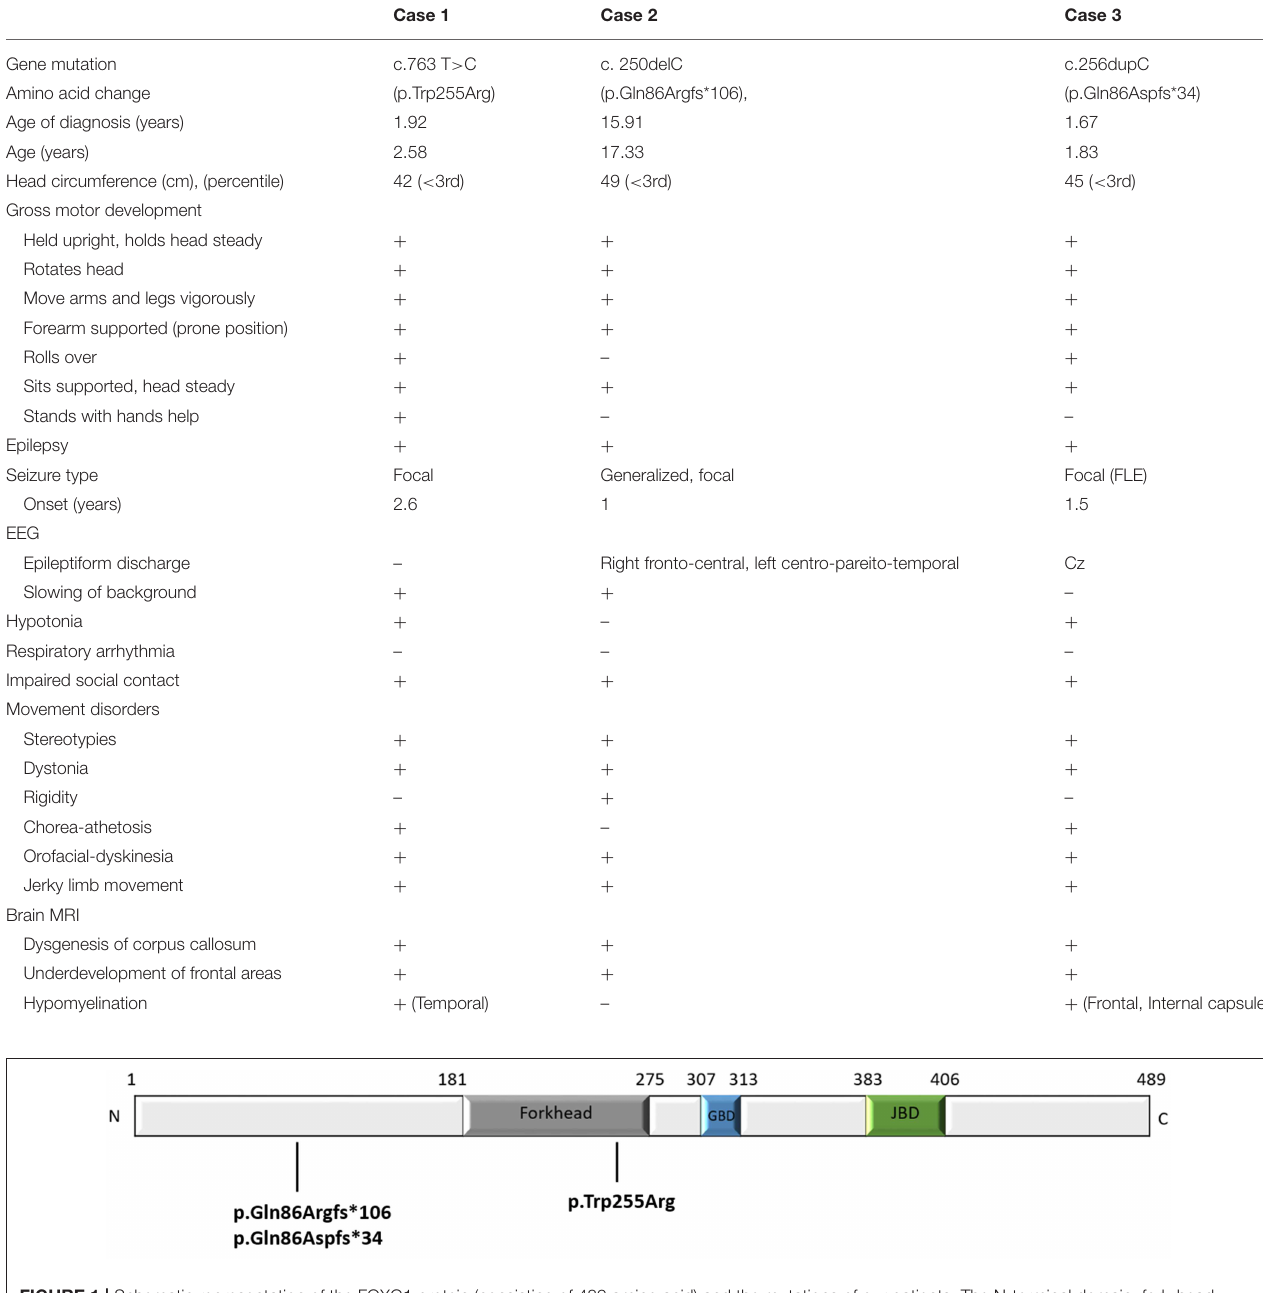
TABLE 1 | Clinical Features of Subjects with FOXG1-related syndrome.